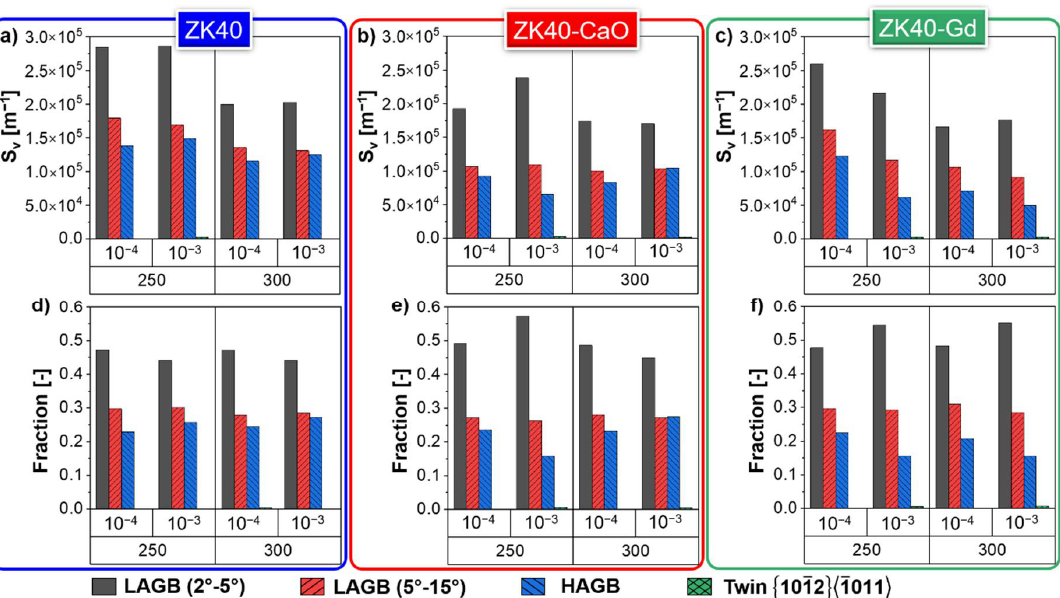
Figure 6. Microstructural features evaluated from the electron backscattered diffraction (EBSD) measurements for the ( a , d ) ZK40; ( b , e ) ZK40-CaO; and ( c , f ) ZK40-Gd. Boundary density ( S v ) ( a – c ) and fraction of boundaries ( d – f ) are shown.